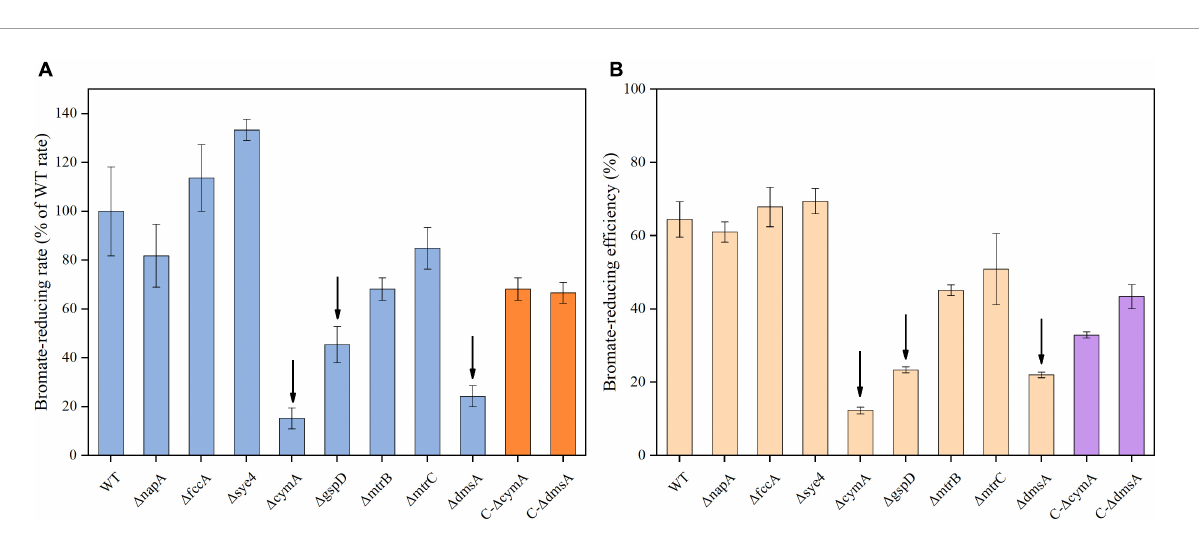
FIGURE2 Microaerobic reduction of bromate at 0.25 mM by the S. oneidensis MR-1 wild type (WT), in-frame deletion mutants ( (cid:49) napA , (cid:49) fccA , (cid:49) sye4 , (cid:49) cymA , (cid:49) gspD , (cid:49) mtrB , (cid:49) mtrC , and (cid:49) dmsA ), and complemented strains (C- (cid:49) cymA and C- (cid:49) dmsA , bromate reduction was performed in the presence of 0.2 mM IPTG). (A) Bromate-reducing rate ( µ Mh - 1 mg protein - 1 ) was calculated from the first 2 h of incubation and normalized to total protein concentration. (B) Bromate-reducing efficiency represents the proportion of reduced bromate (at 12 h) in the initial bromate. Error bars represent standard deviations of triplicate